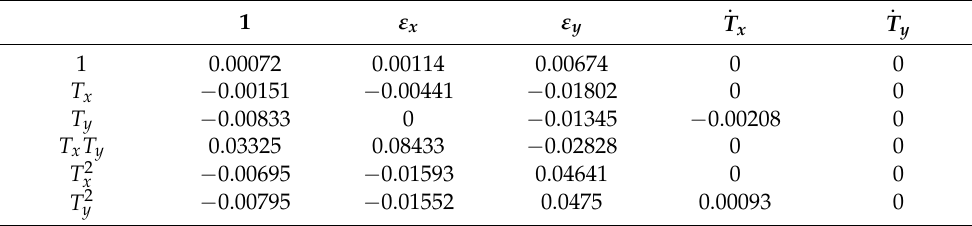
Table 9. Fitting results for (cid:101) D ty , tx